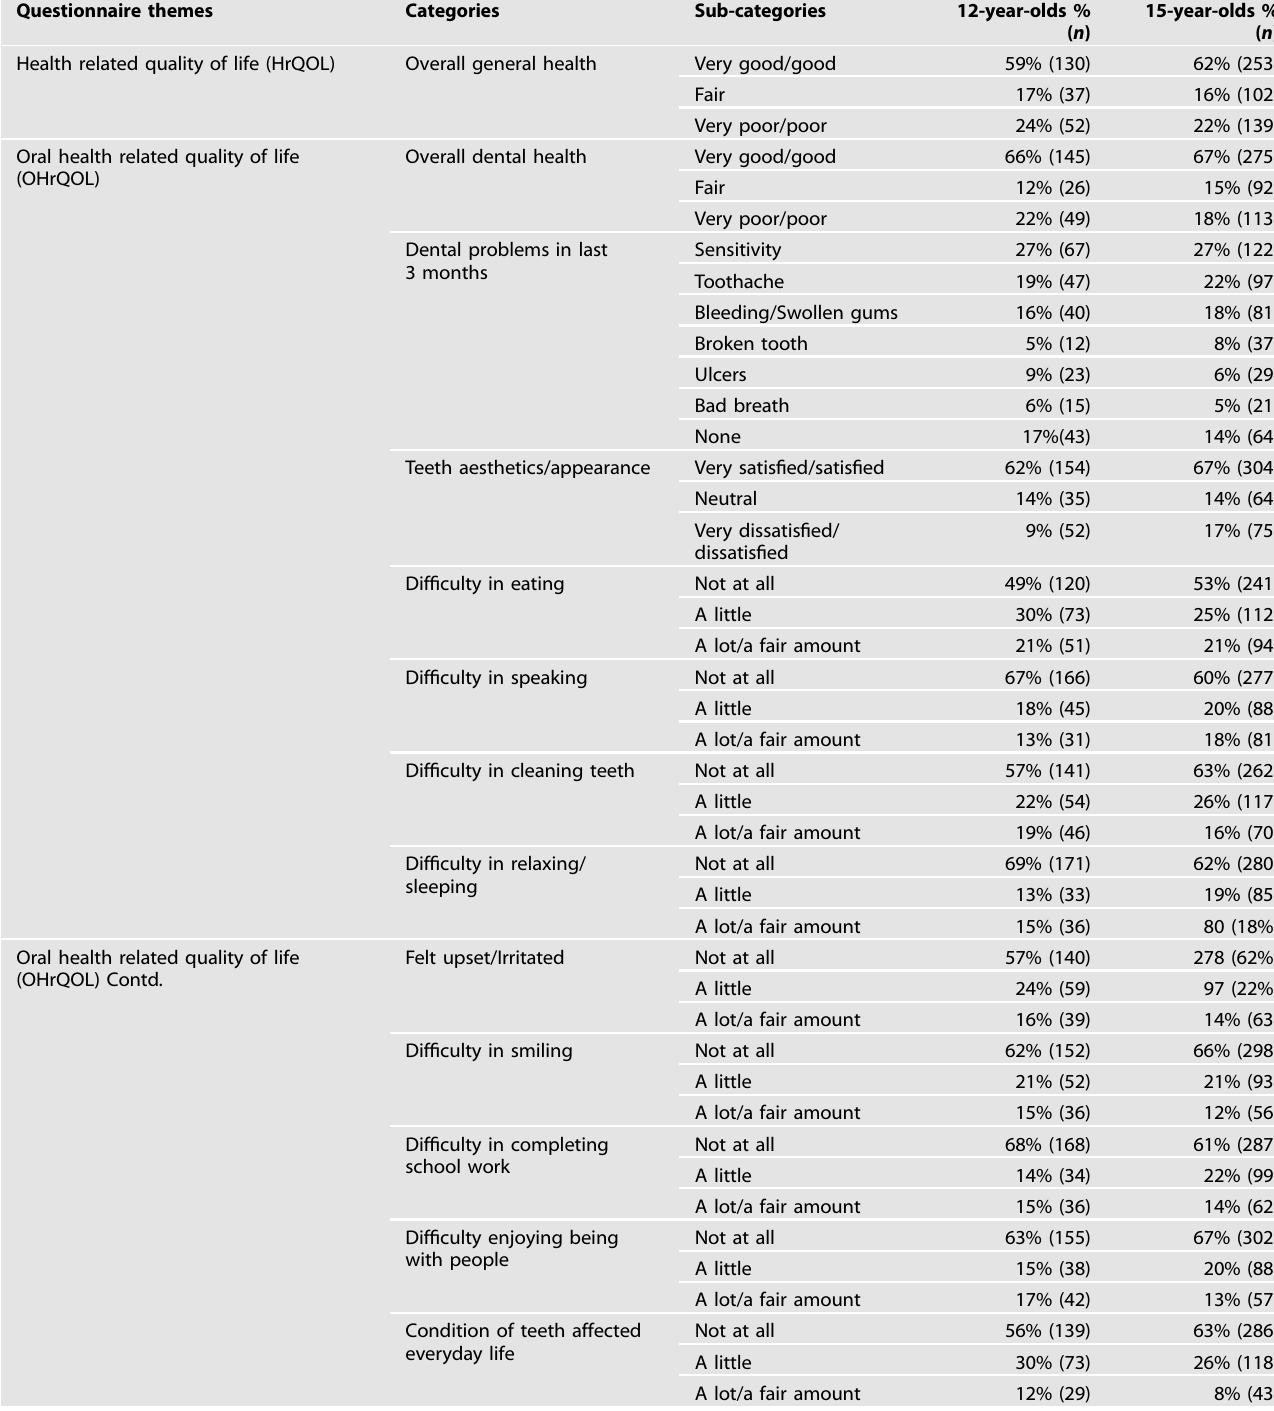
Table 4. Descriptive fi ndings for health and oral health related quality of life from pupil questionnaire for 12- and 15-year-olds. Questionnaire themes